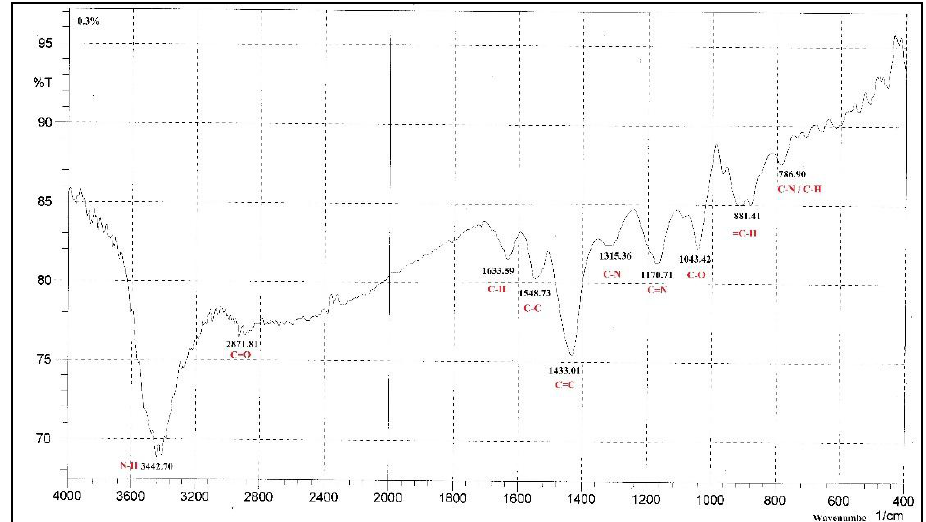
Fig. 8: (a) FTIR spectra of PPy with (0.3%) of GN nanocomposite.